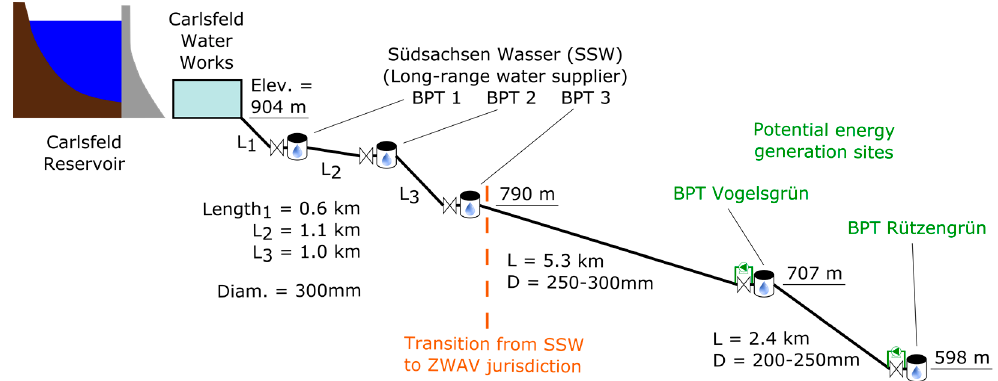
Figure 5. Diagram of the Carlsfeld supply system, with break pressure tank (BPT) Vogelsgrün and BPT Rützengrün. As illustrated in Figure 1, the potential turbines would be positioned in parallel with the existing pressure control valves.